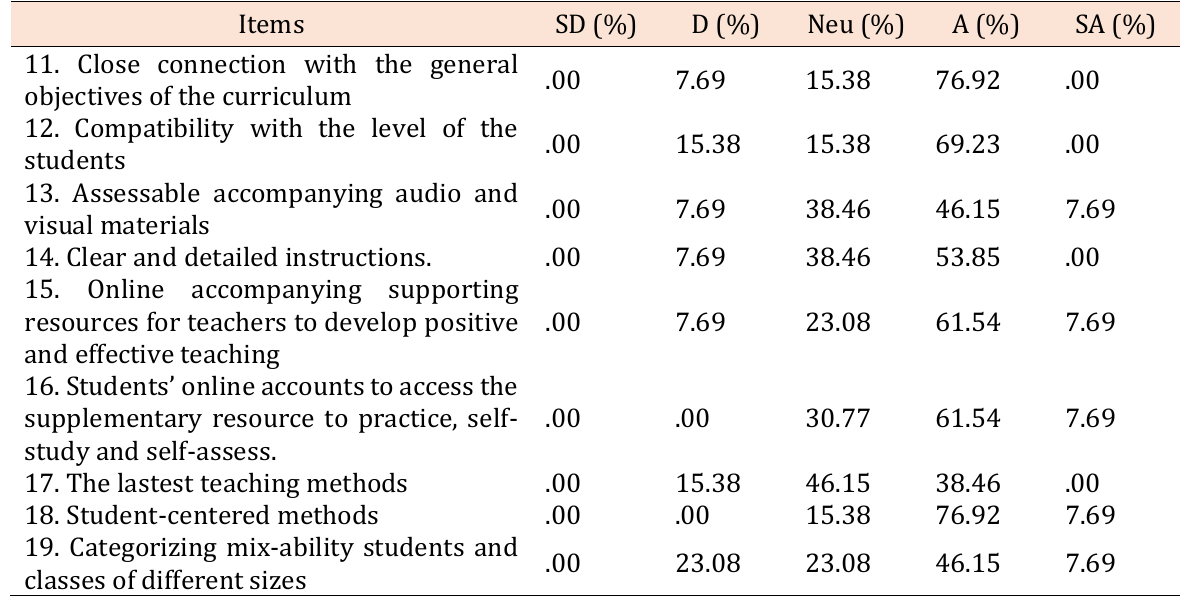
Table 4. EFL teachers’ evaluation of Efficient layout of objectives and supplementary